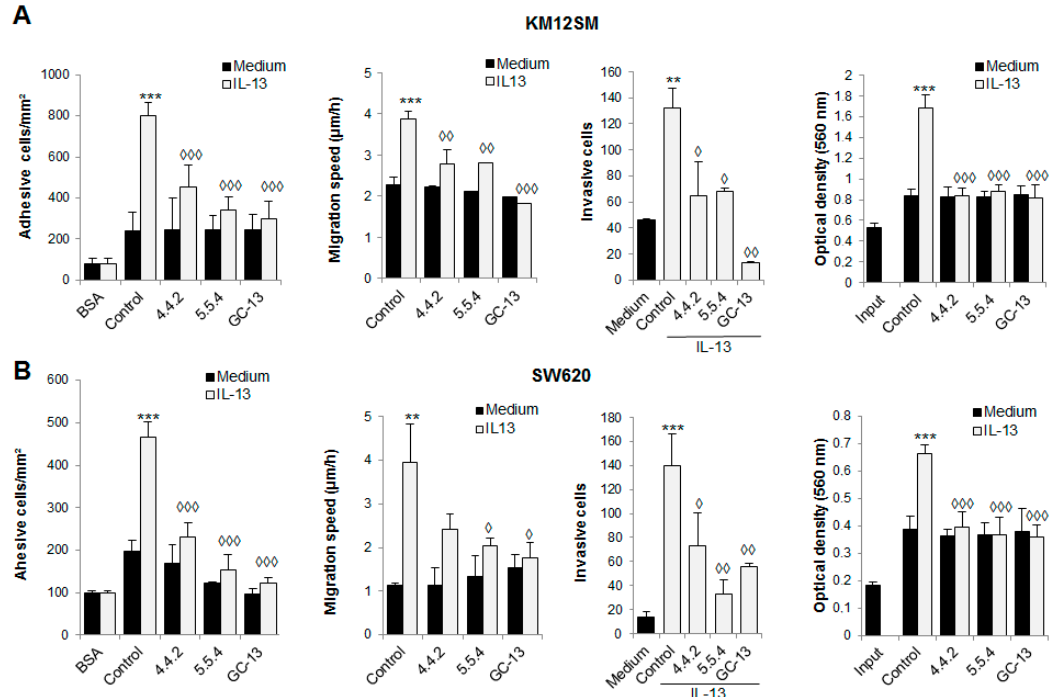
Figure 3. Inhibition of IL-13 prometastatic capacities. ( A , B ) Metastatic KM12SM and SW620 colorectal cancer cells were treated with IL-13 (10 ng/mL) and subjected to cell adhesion, wound healing, invasion and MTT assays in the presence of the anti-IL13R α 2 D1-specific mAbs, chicken antibody GC-13 or a control antibody. The presence of IL-13 significantly increase cell invasion, adhesion, migration and proliferation (** p < 0.01; *** p < 0.001), whereas anti-IL13R α 2 D1 peptide antibodies significantly inhibited these pro-metastatic capacities triggered by IL-13 ( ♦ p < 0.05; ♦♦ p < 0.01; ♦♦♦ p < 0.001). In proliferation assays, “input” means cells collected “ab initium”, i.e., cells allowed to adhere to the plate for 1 h at 37 ◦ C and then incubated for 1 h with MTT before absorbance was determined. For the other conditions, cells were incubated with 1% serum for 48 h at 37 ◦ C and then incubated with the MTT reagent.